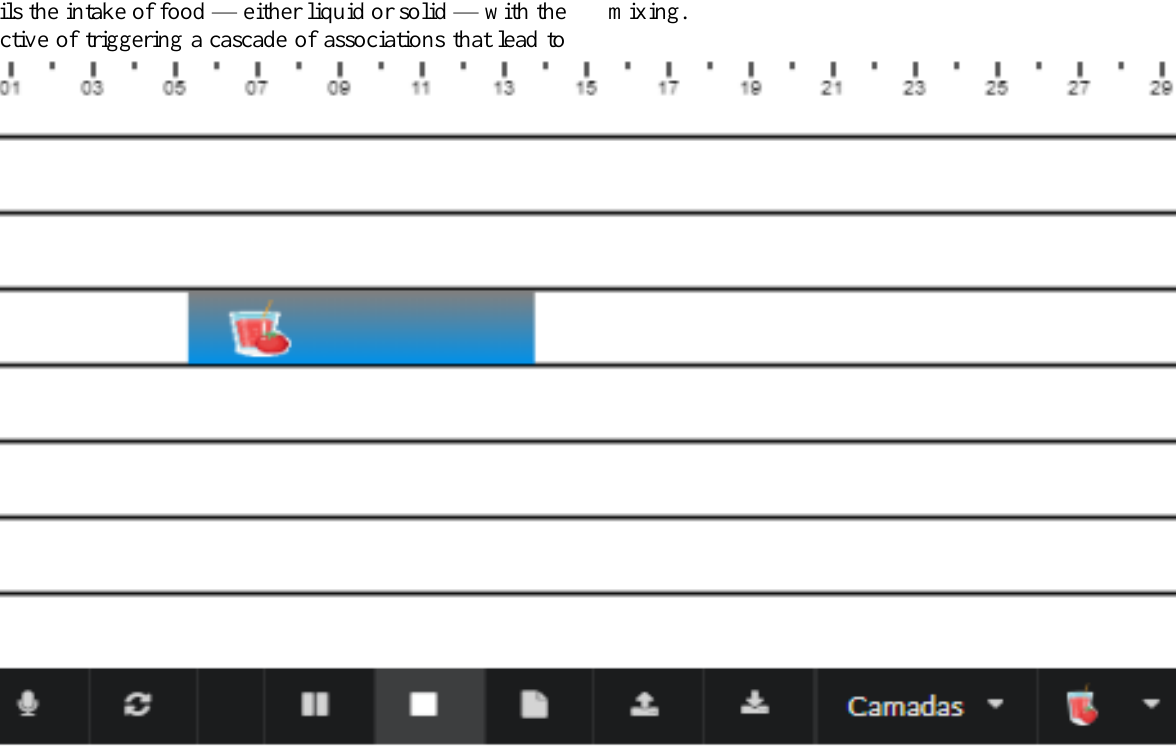
Figure 1. Using a tomato-juice gastroicon in the prototypes leading to the design of SoundSphere 1.5: An event may take place from second 5 to second 14 within the mix. The participant takes a sip of tomato juice within this temporal